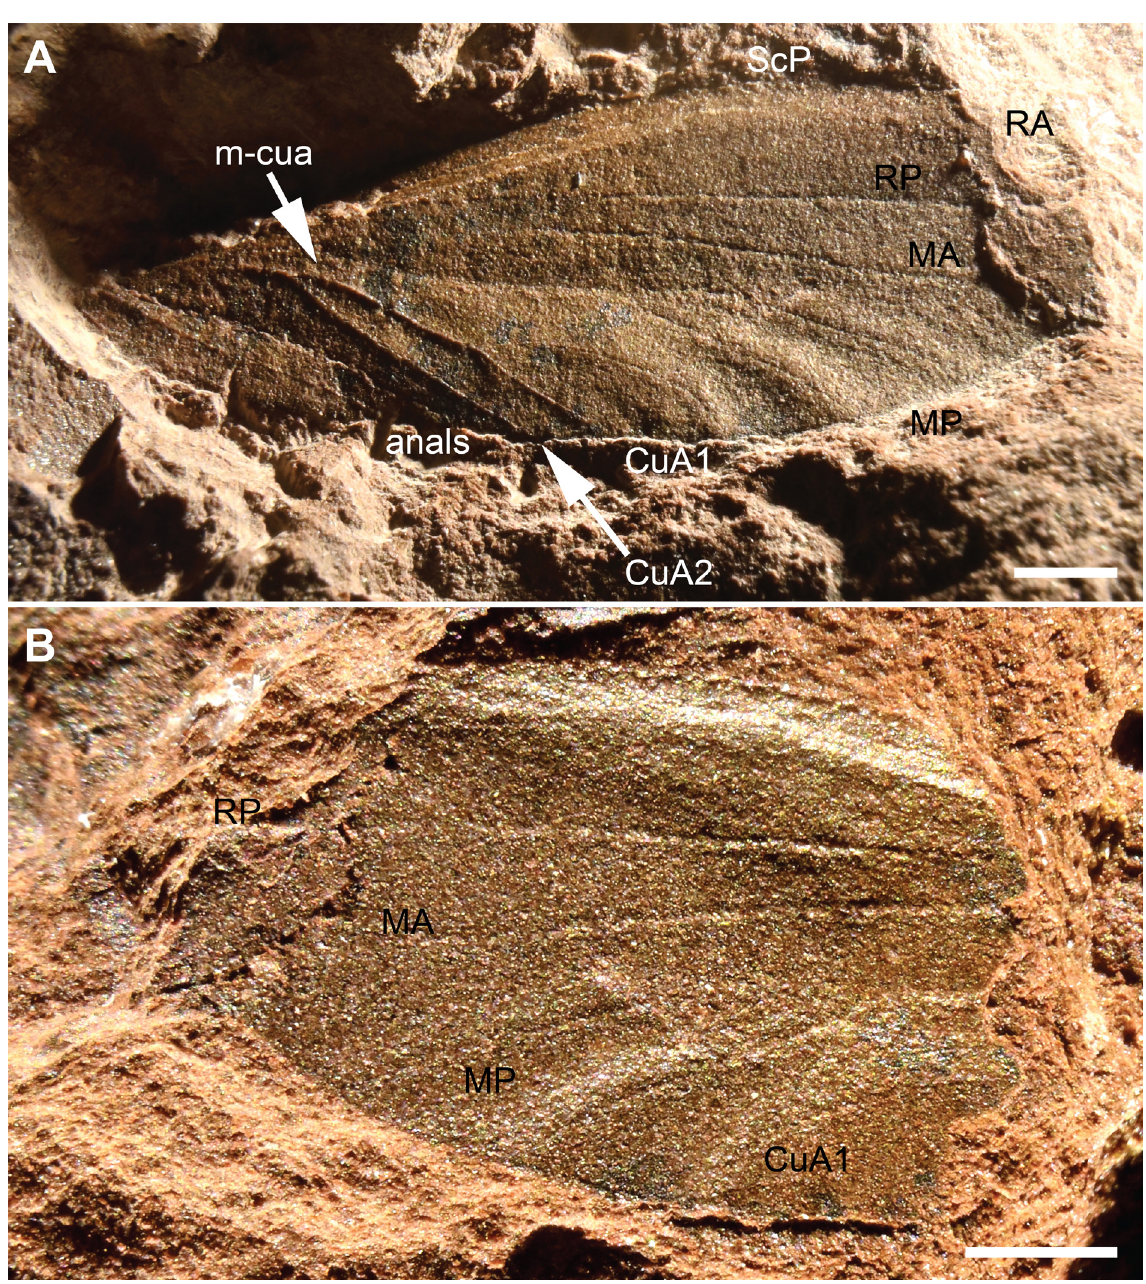
Fig. 1. Lodevoisadia coheni gen. et sp. nov., holotype 2022.3.2. Photographs. A . Part. B . Counterpart of wing apex. Scale bars = 1